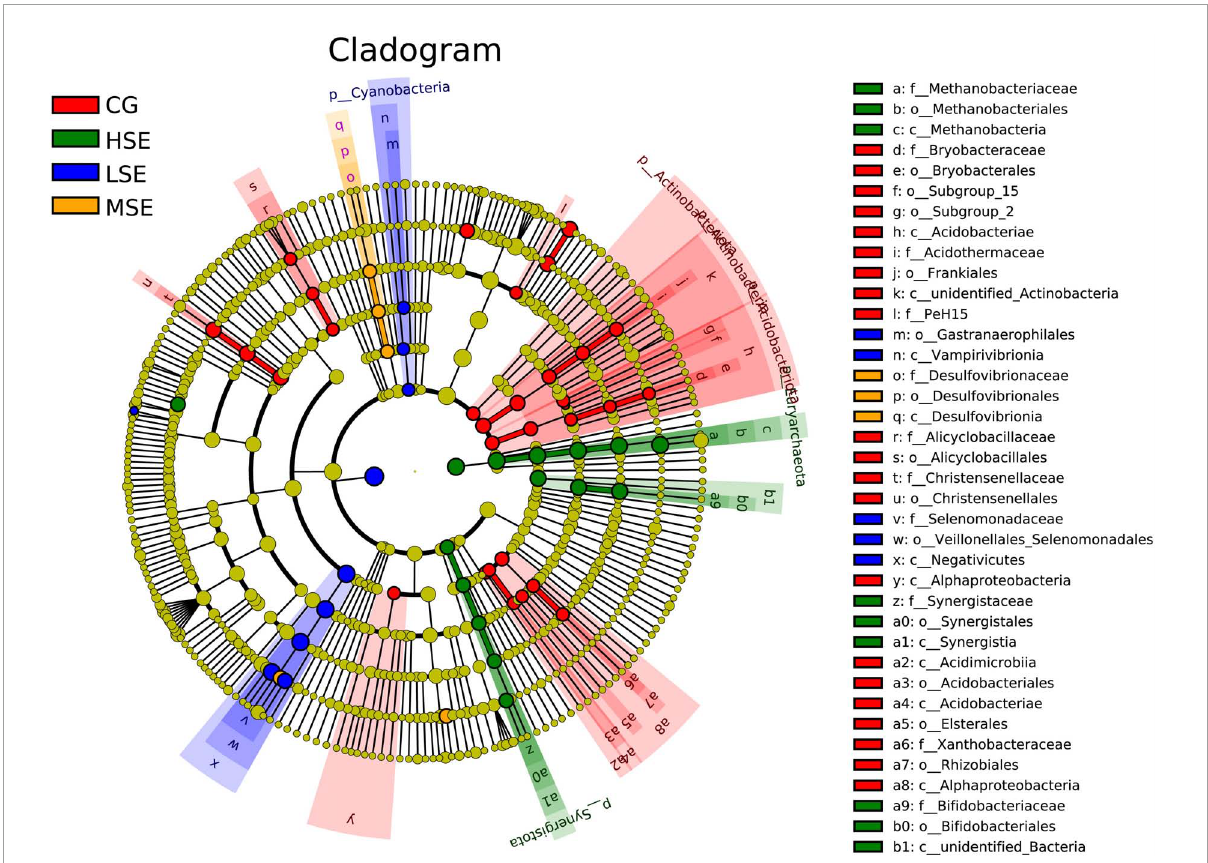
FIGURE4 Cladogram of significantly different taxa identified in the rumen microbiome data sets of different SeHLan supplemented groups based on the cut-off of LDA > 3.0 and P < 0.05. Clades significantly enriched in each cohort are highlighted by the colors shown in the legend. There are six layers from the inside of this plot to the outside, corresponding to six levels of taxonomy (phylum, class, order, family, genus, and species). The nodes (small circle) with different colors represent bacterial biomarkers of in the corresponding groups with the higher abundance compared with that in the other three groups, while yellow nodes indicate the bacteria that are not statistically and biologically differentially abundant among the four groups. CG, control group; LSE, low Se group; MSE, medium Se group; HSE, high Se group.